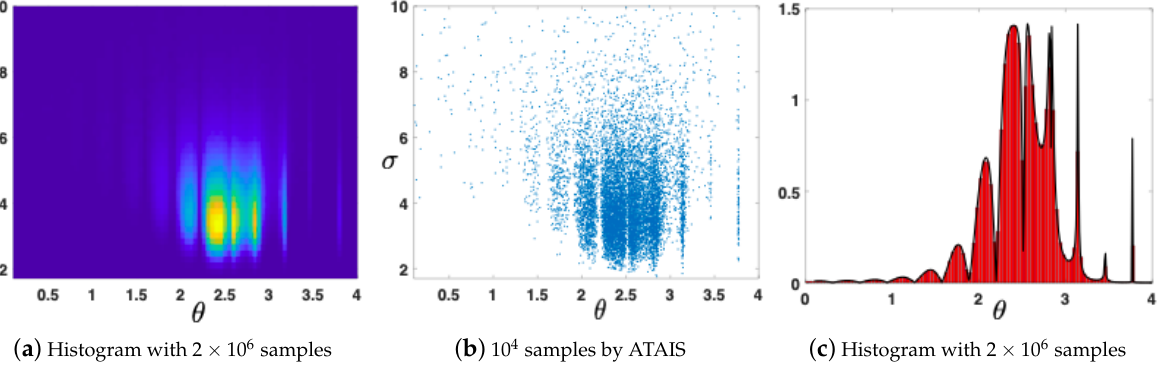
Figure 4. Approximations obtained with ATAIS. ( a , b ) Joint posterior p ( θ , σ | y ) : (a) by an histogram with 2 × 10 6 samples; (b) 10 4 samples from joint posterior obtained by ATAIS. ( c ) Approximation by an histogram with 2 × 10 6 samples, of the marginal posterior p ( θ | y )